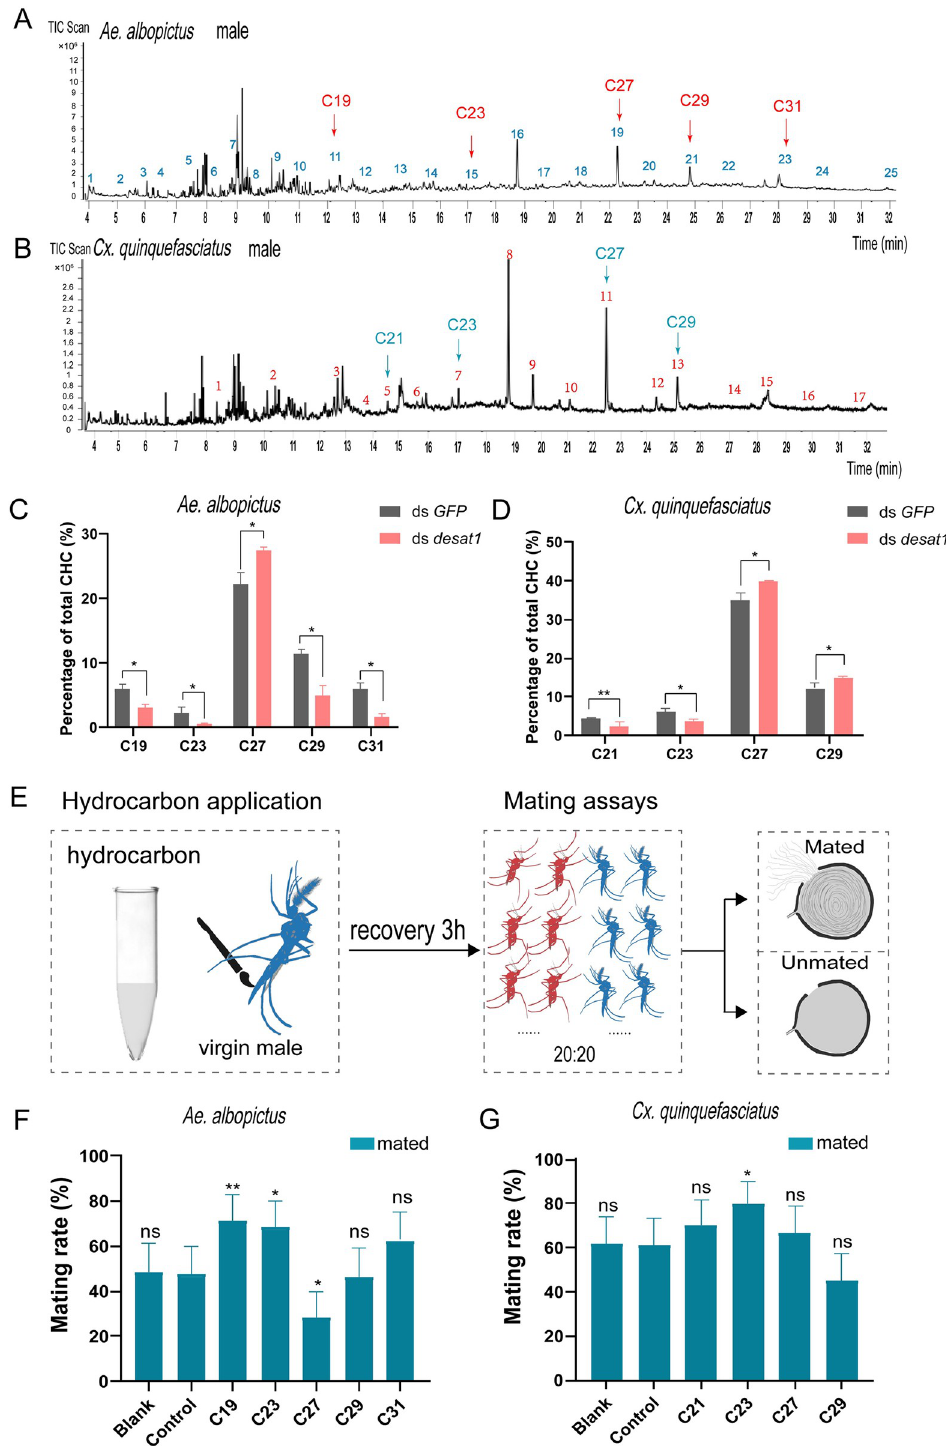
Fig 4. Silencing of desat1 changed the CHC profiles of male Ae . albopictus and Cx . quinquefasciatus and altered mating activity. (A-B) Representative CHC profiles of male Ae . a lbopictus ( A ) and Cx . quinquefasciatus ( B ) on day 4 after GFP ds RNA injection. Numbers above the peaks correspond to peak numbers given in S3 and S4 tables. Comparison of CHCs between mosquitoes injected with ds GFP and ds desat1 in Ae . a lbopictus ( C ) and Cx . quinquefasciatus ( D ). The gray bars represent the groups injected with GFP dsRNA, and the pink bars represent